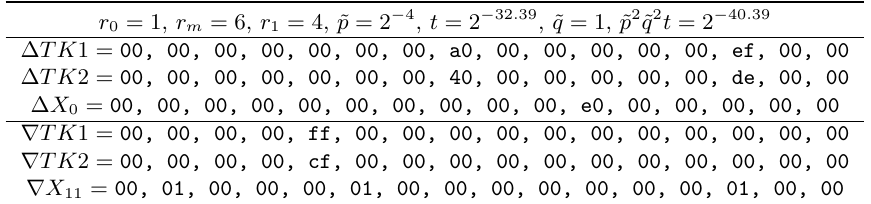
Table 24: The 11-round related-tweakey boomerang distinguisher for SKINNY-128-256 .